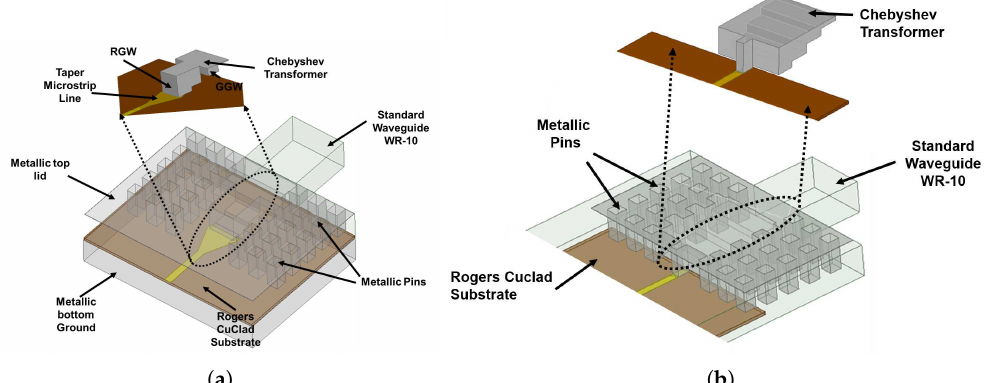
Figure 1. 3D view of the proposed microstrip to rectangular waveguide transitions. ( a ) Dielectric-filled ridge and groove gap waveguide-based transition (RW-RGW-GGW- µ strip). ( b ) Groove gap waveguide- based transition (RW-GGW- µ strip).